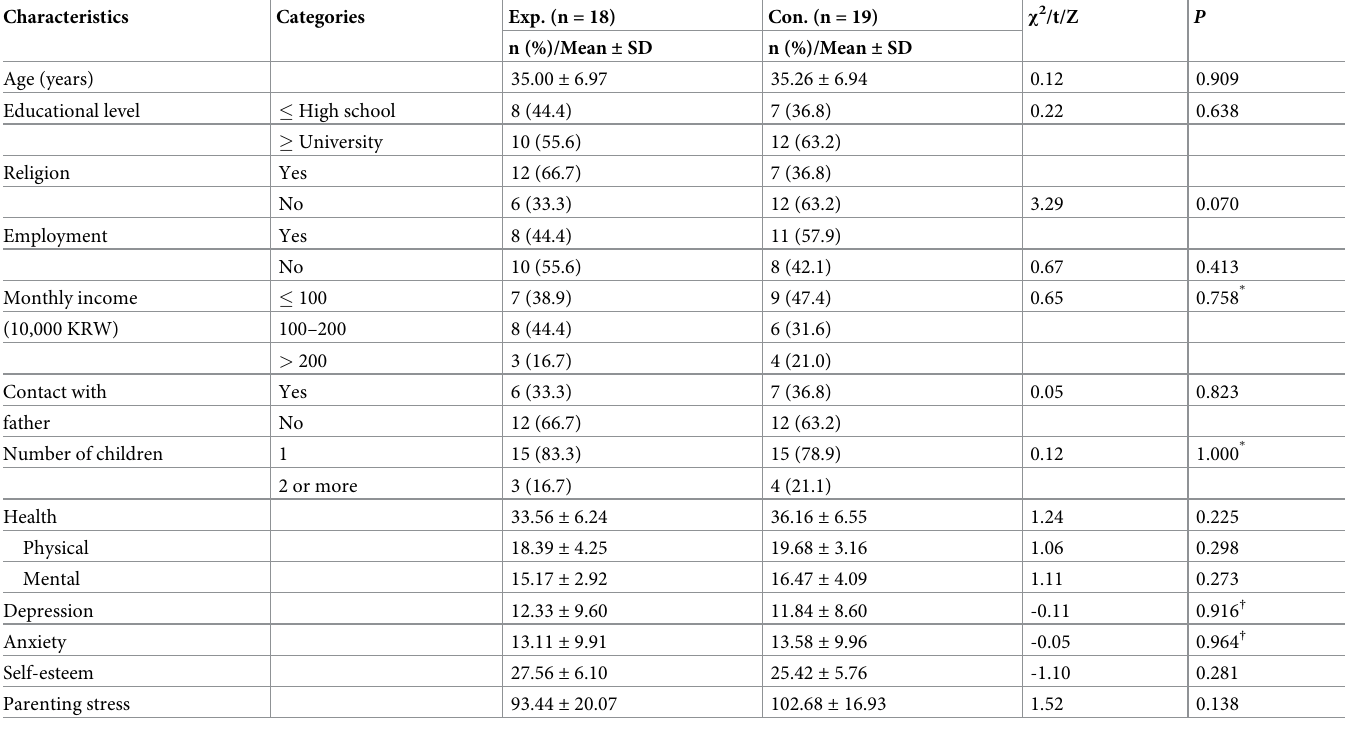
Table 2. Homogeneity test of general characteristics and outcome variables between the two groups at baseline (N = 37). Characteristics